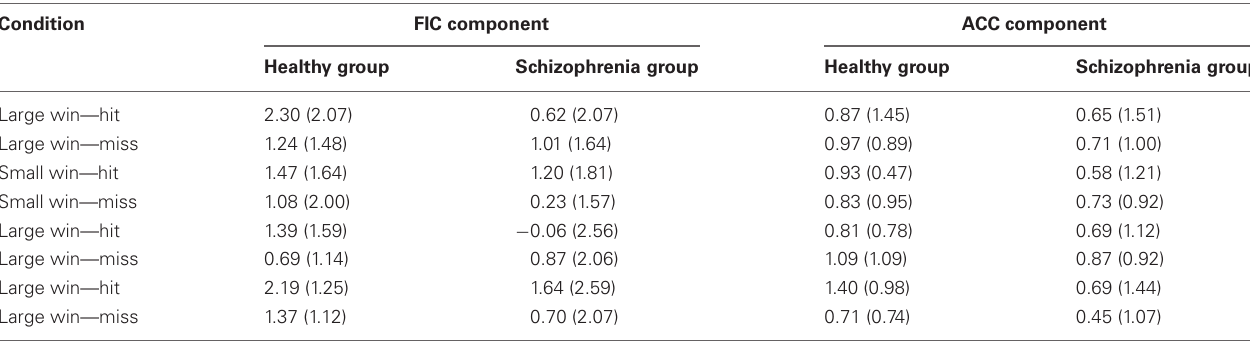
Table 5 | Beta coefficients for salience network responses at